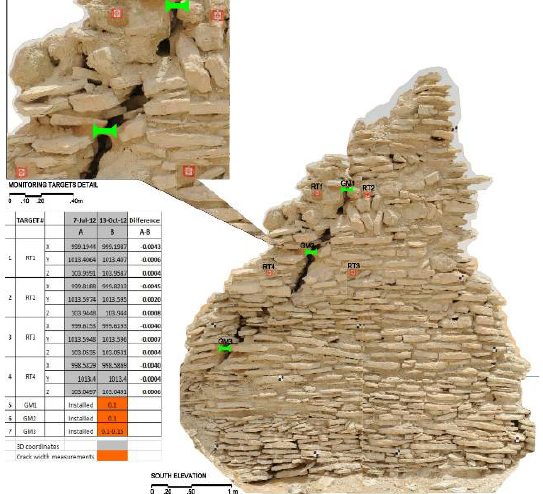
Figure 10. The rectified south elevation shows the locations of targets and gypsum monitors recorded with total